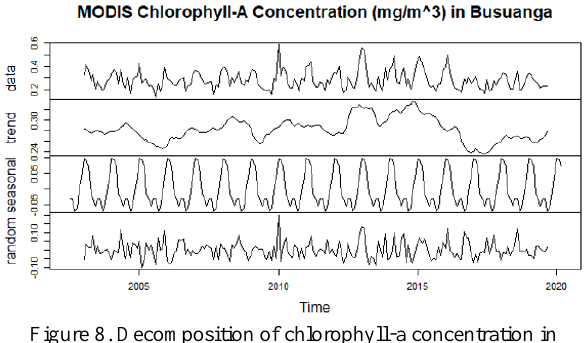
Figure 8. Decomposition of chlorophyll-a concentration in Busuanga from MODIS